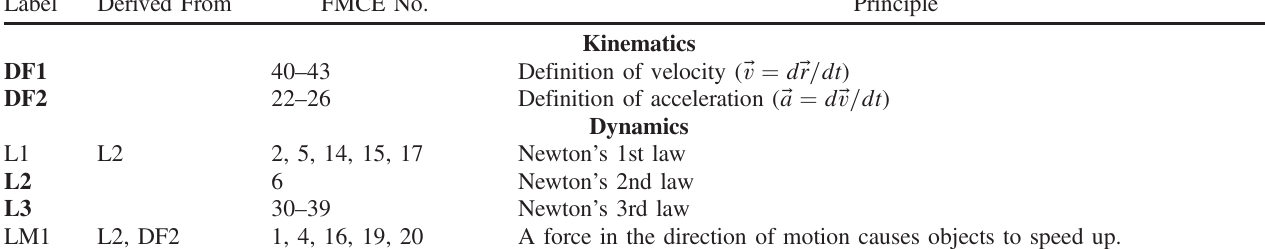
TABLE IV. Theoretical model of Newtonian mechanics as tested by the FMCE. Principles in bold were included in the optimal model. Label Derived From FMCE